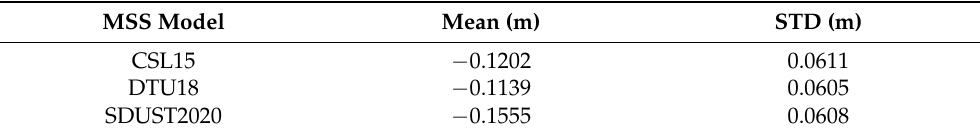
Table 5. The comparison results of the difference between the grid mean sea height data and MSS models.